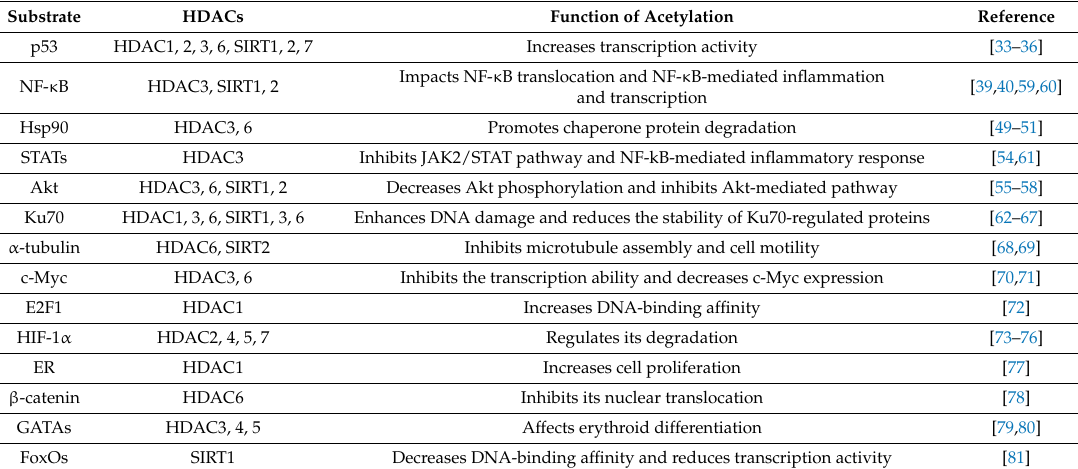
Table 1. Non-histone proteins deacetylated by histone deacetylases